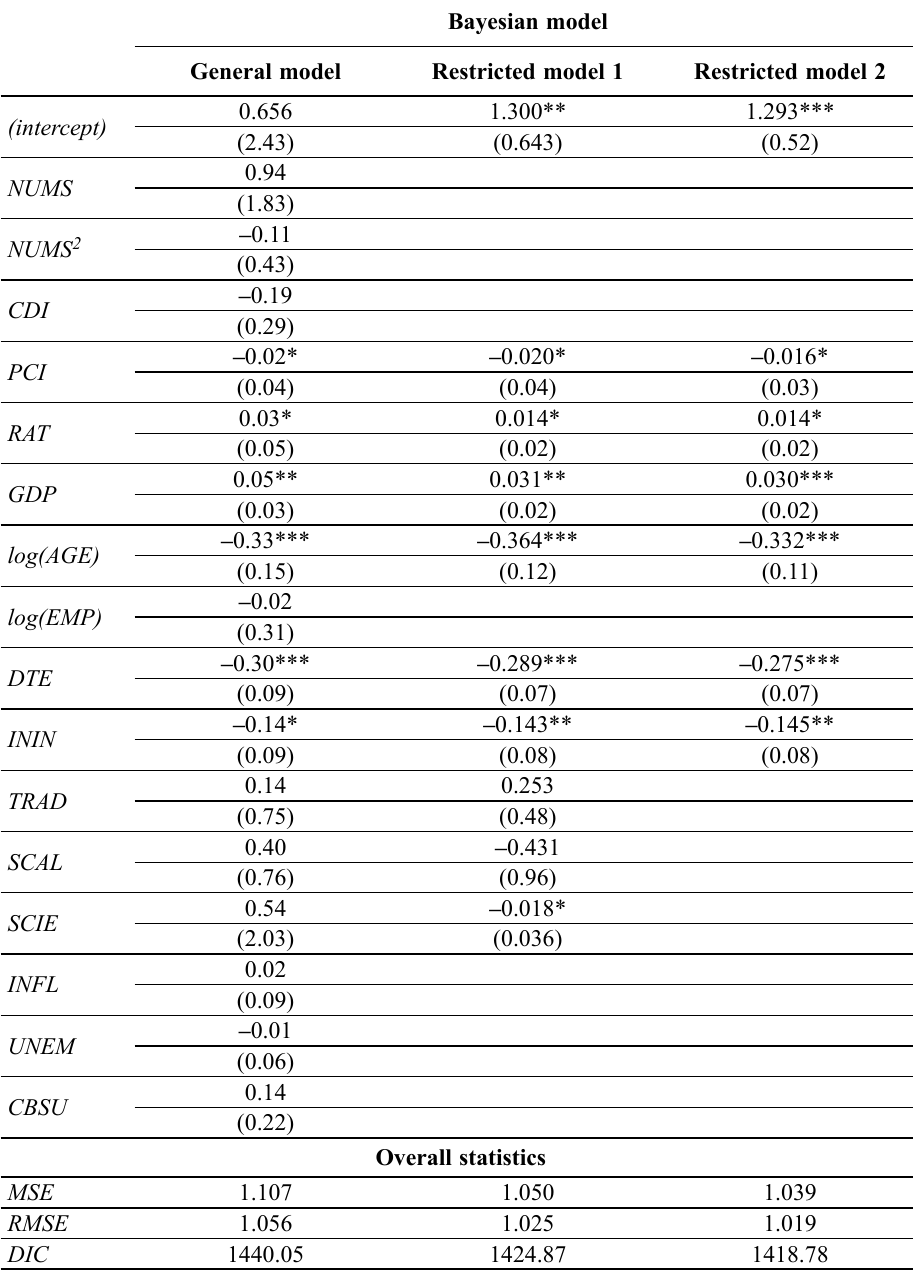
Table 4. Bayesian Model’s parameters